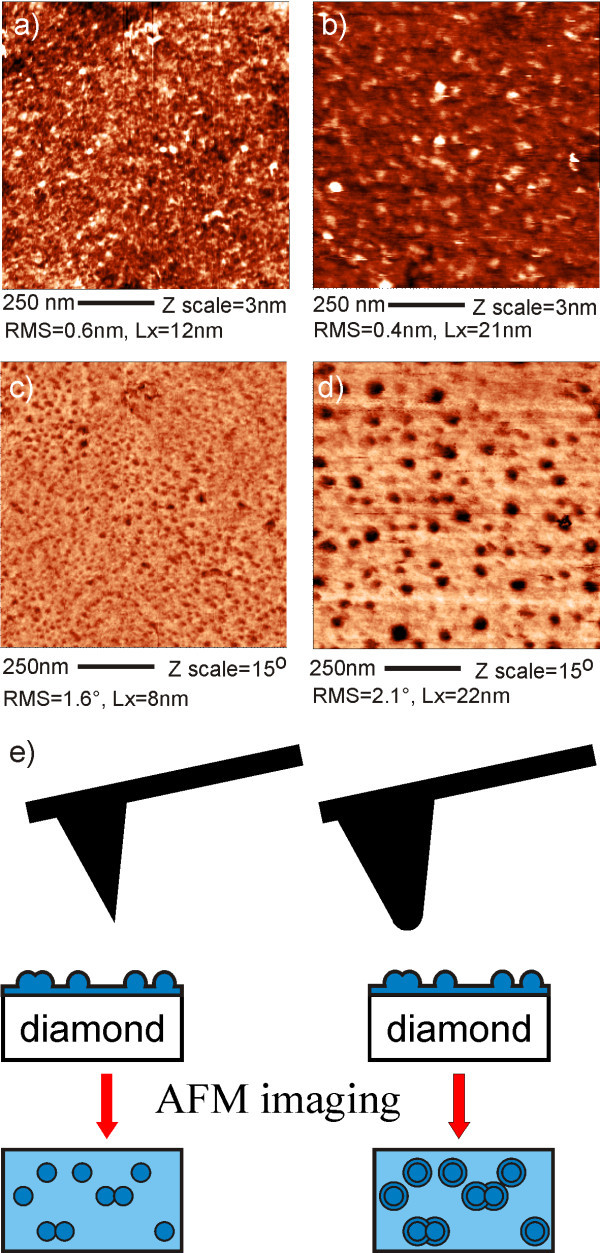
Influence of the tip radius on AFM topography and phase. AFM topography (a, b) of FBS layer on H-terminated MCD obtained in solution using cantilevers with different tip radius. Estimated tip radius ra ~ 30 nm, rb ~ 50 nm. Lxa = 12 nm, Lxb = 21 nm. Corresponding AFM phase images (c, d) show the difference in Lx values for phase (Lxc = 8 nm and Lxd = 22 nm). (e) The model illustrates the effect of tip shape on the broadening of features in the phase images.